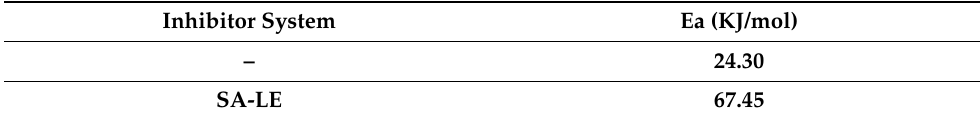
Figure 7. Arrhenius plot for corrosion of mild steel in 1.0 M HCl for solution with 10% SA-LE inhibitor. Table 9. Average activation energy for corrosion of mild steel in 1.0 M HCl in the absence and in the presence of SA-LE leaf aqueous extract (10% v / v ).